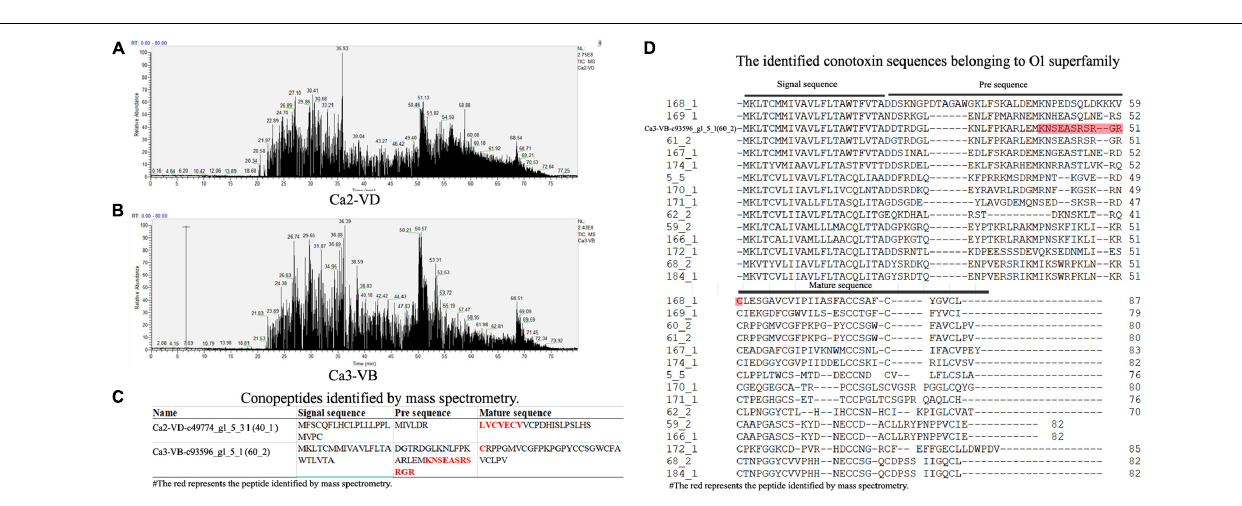
FIGURE 3 | The results of the LC-MS/MS analysis. (A) , Total ion current traces of the VD from C onus caracteristicus Ca2. (B) , Total ion current traces of VB from C . caracteristicus Ca3. (C) , The sequence fragments identified by LC-MS/MS. (D) , Sequence alignment of 15 O1 superfamily